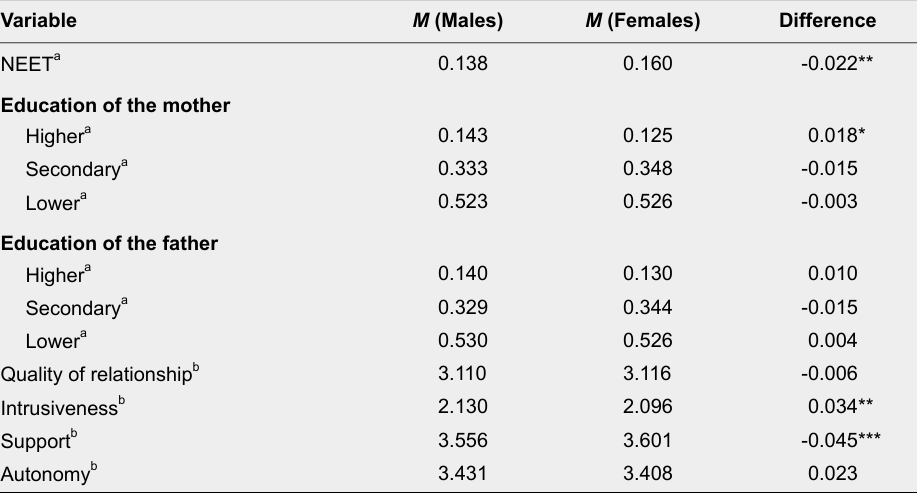
Summary Statistics of the Dependent and Independent Variables Used in the Analysis, by Gender